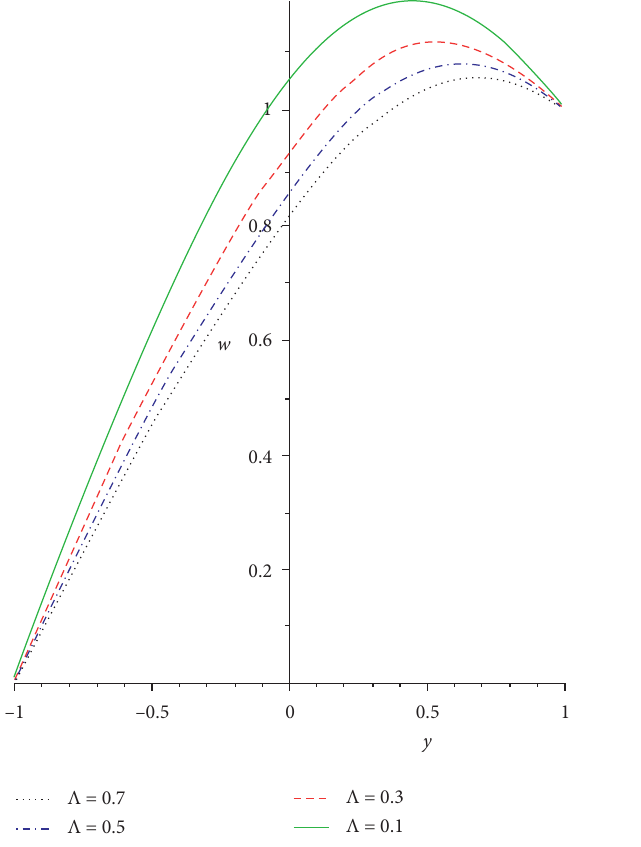
Figure 4: Flow rate field for various values of Λ . Figure 5: Heat profile for rising values of n